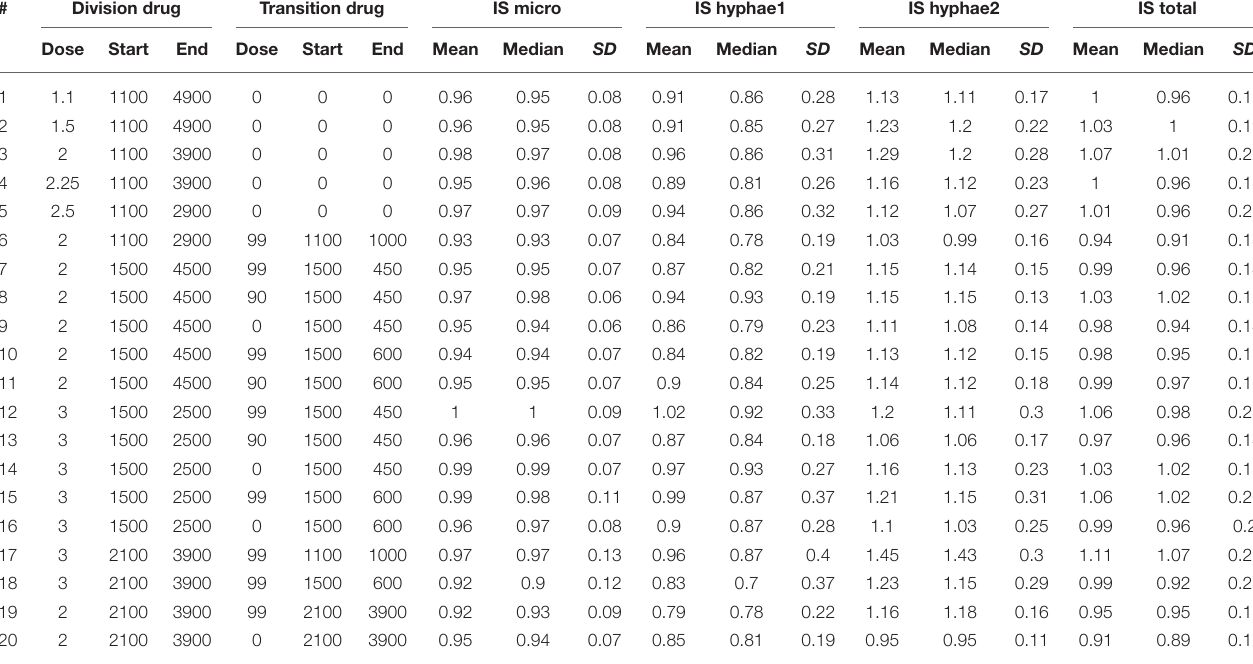
TABLE 2 | Overview on the 20 best treatment scenarios as shown in Figure